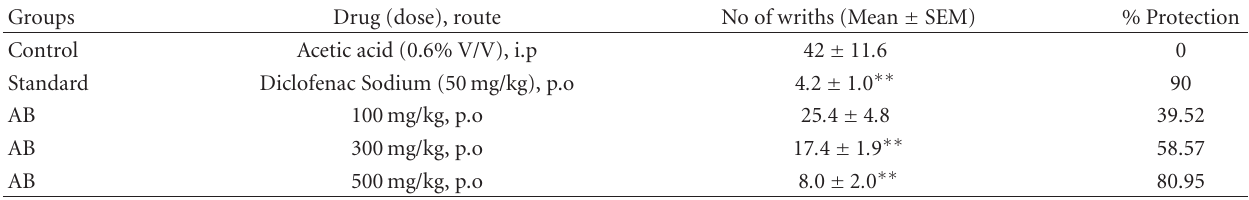
Table 3: Protective efeect of Pinus roxburghii Sarg. on writhing induced by acetic